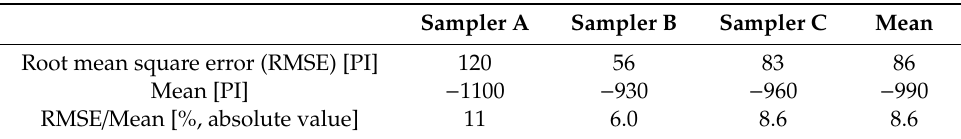
Table A4. Root mean square error (RMSE), calculated relative to the mean value (among triplicate low-cost passive samplers), in estimated change in reflectance (change in mean pixel intensity ( ∆ PI; unitless)) for all sampling time-points ( n = 18).